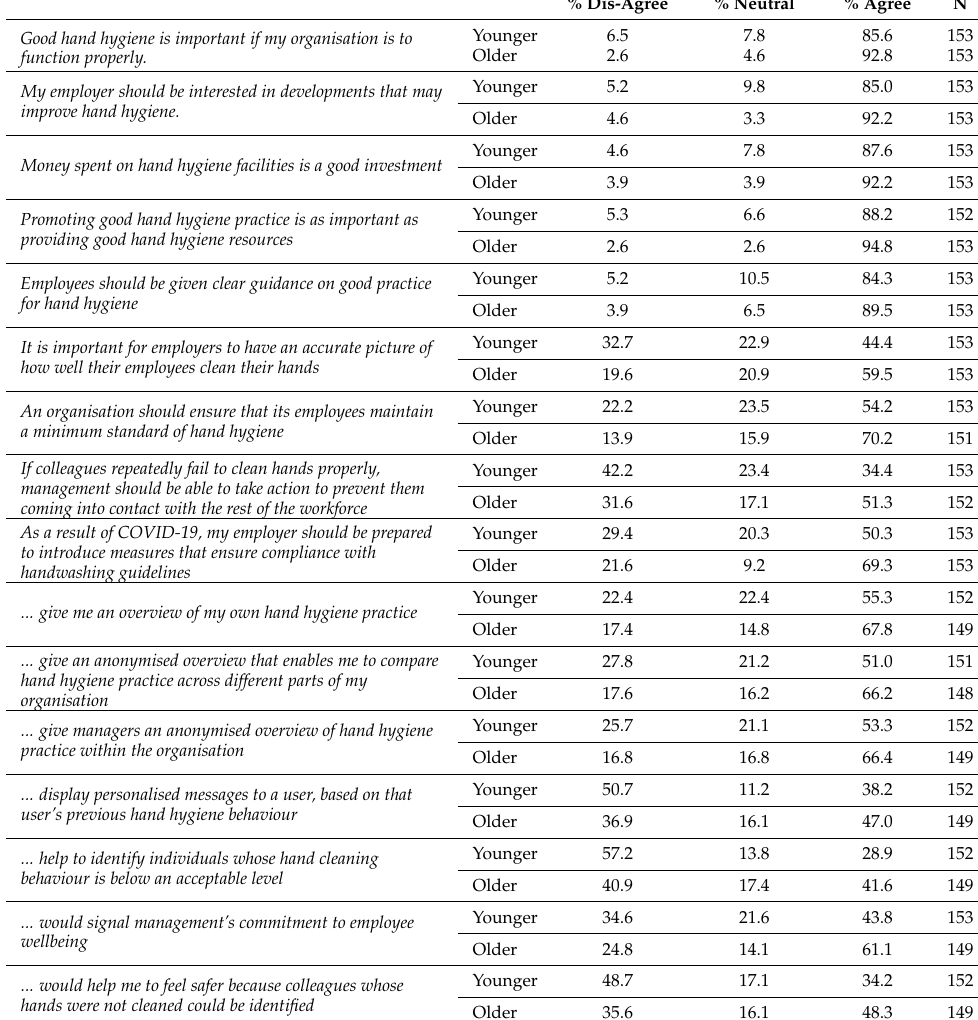
Table 9. Statements positively correlated with the age of the respondent. Spearman rank correlation, p < 0.01. (Older ⇒ > median, Younger ⇒ < median). N indicates the no. of people from the Younger or Older age group who responded to the statement.